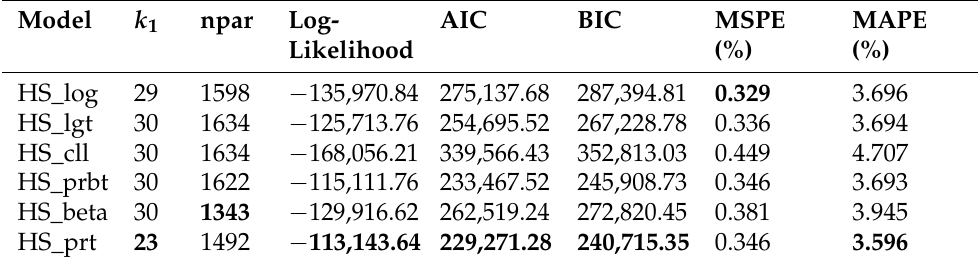
Table 4. Results of the quantitative tests for E&W mortality